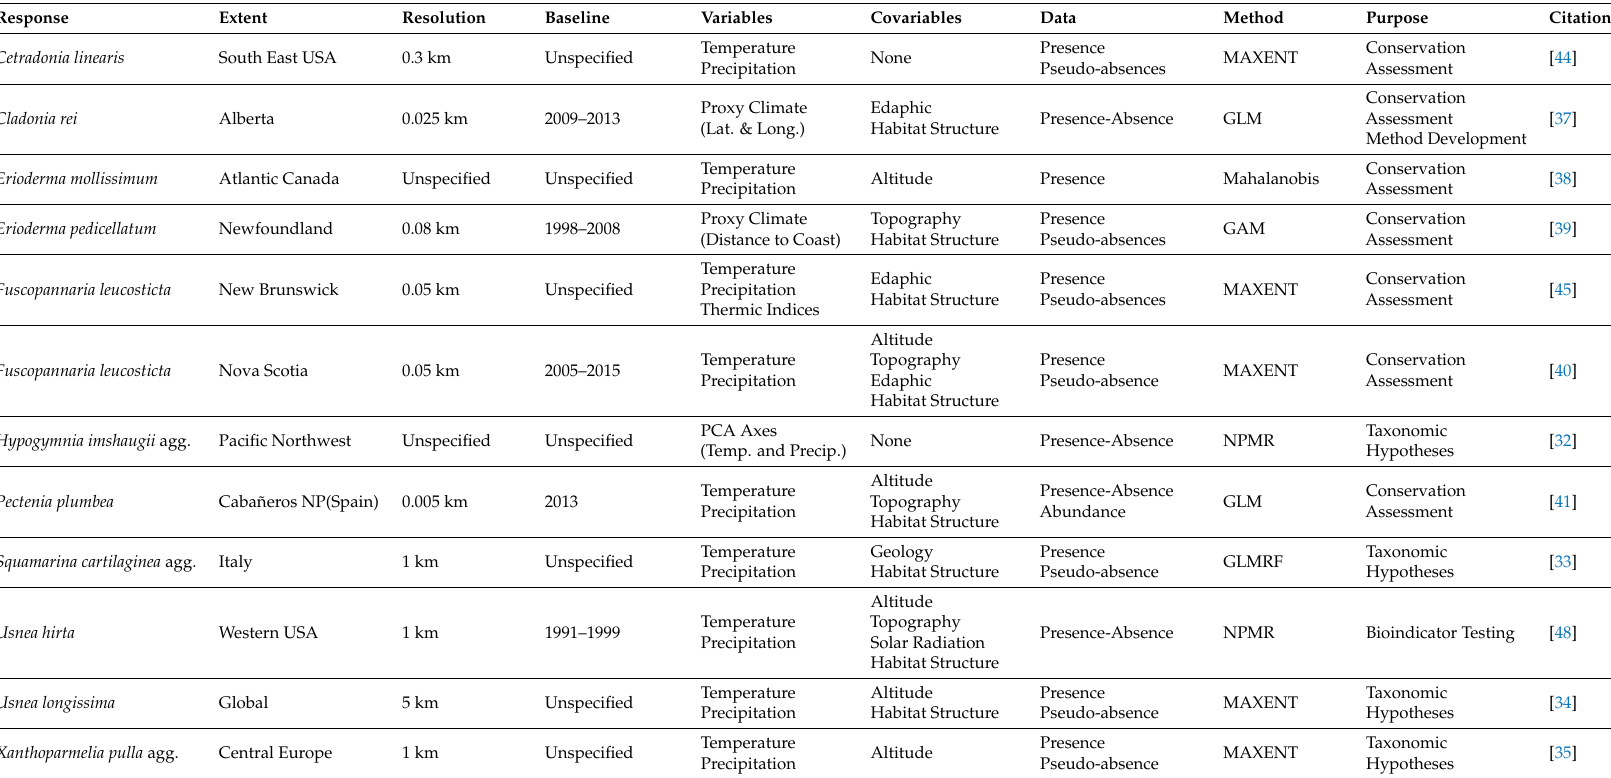
Table 1. Examples of bioclimatic modelling studies on lichens, investigating response to the baseline climate only. The list is not exhaustive and is drawn primarily from the Web of Science Core Collection under the Boolean search terms for a period 1990–2018: ‘lichen AND climat* AND model* AND (bioclimat* OR species distribution OR habitat suitability)’. Examples are further restricted to studies that use distributional data to understand the response of individual lichens (mycobiont and photobiont in symbiosis), as opposed to community response (composition/richness) or functional